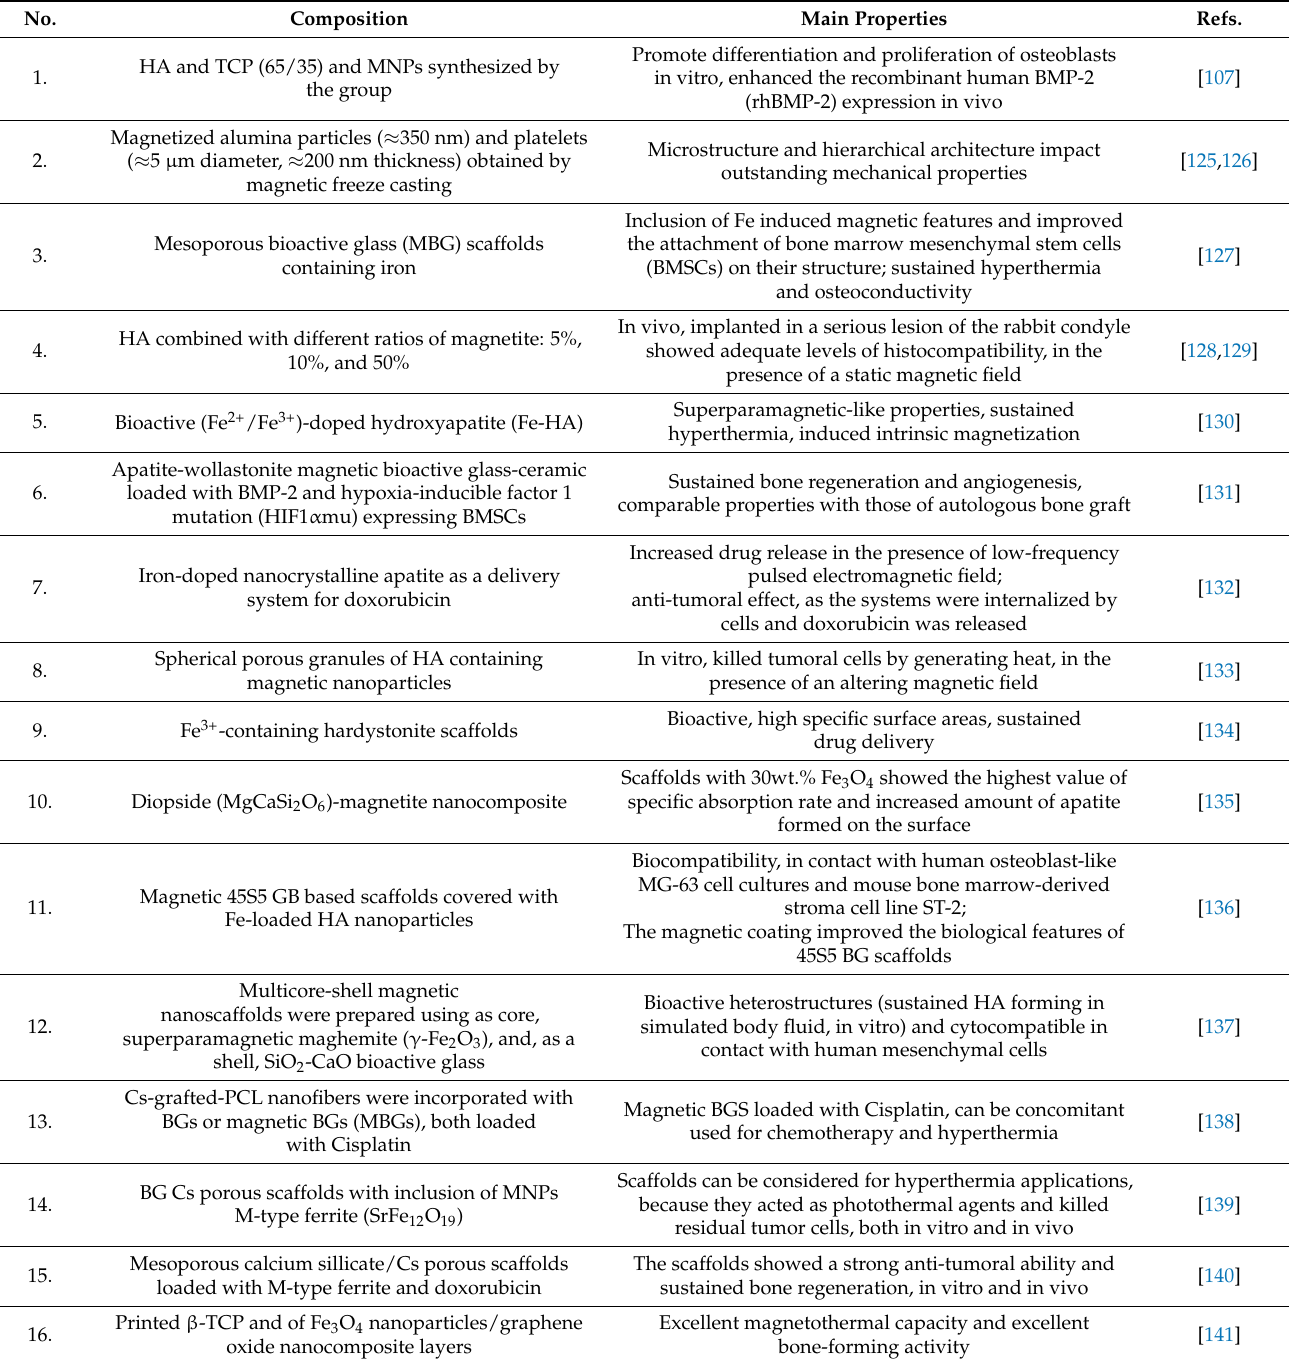
Table 1. Magnetic bioceramics